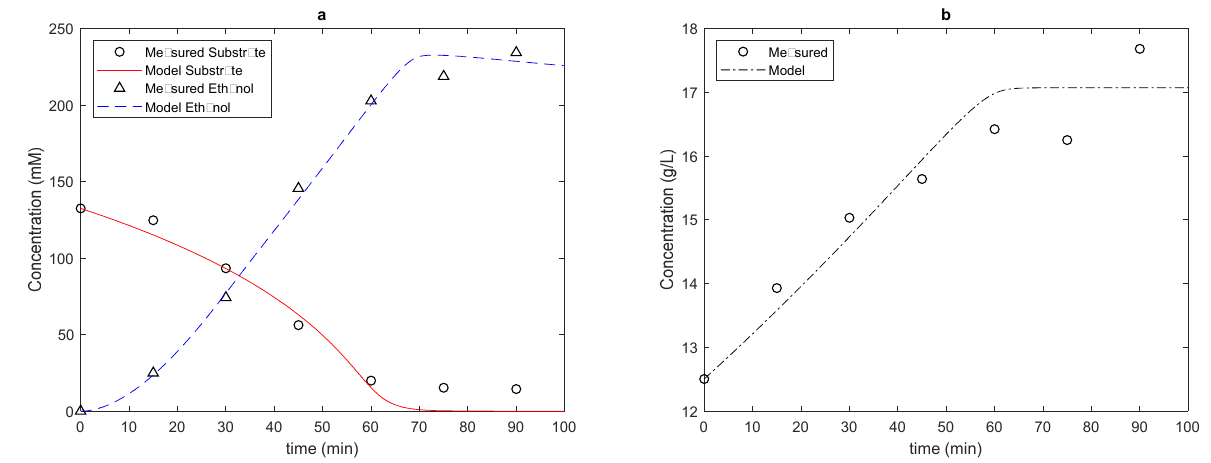
Figure 5. ( a ) Result of the CR model with an initial concentration of 30 g/L, and ( b ) adjustment of cell concentration. Source: prepared by the author.